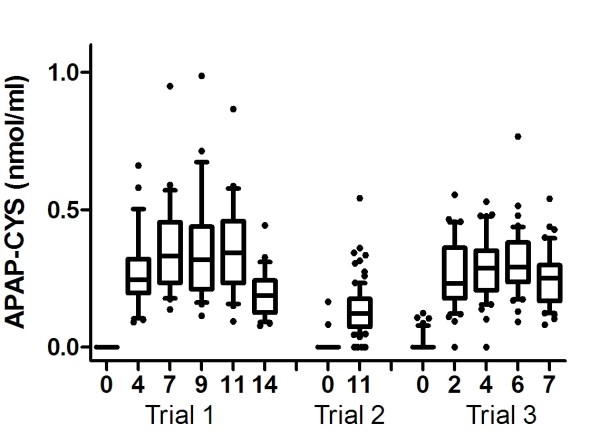
Serum APAP-CYS concentrations for subjects in three trials. Subjects received 4 g/day of acetaminophen for 10 days (Trials 1 and 2) or 5 days (trial 3) starting at day 1. Bars represent the 10-90th percentile for each study and values outside that range are shown as '•'.